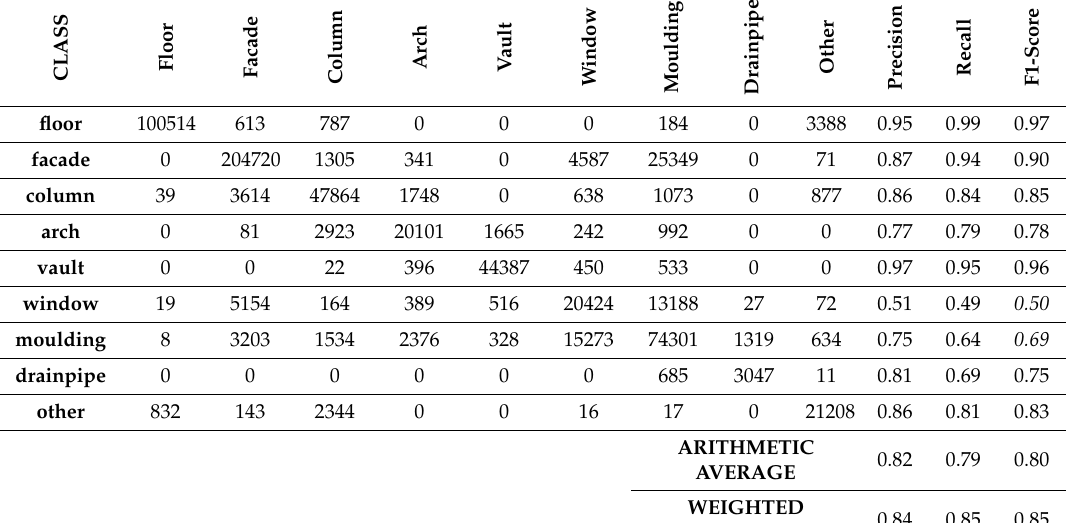
Table 5. Evaluation metrics: generalisation level #3, dataset D. The most critical F1 values are reported in italics ( window and moulding classes).